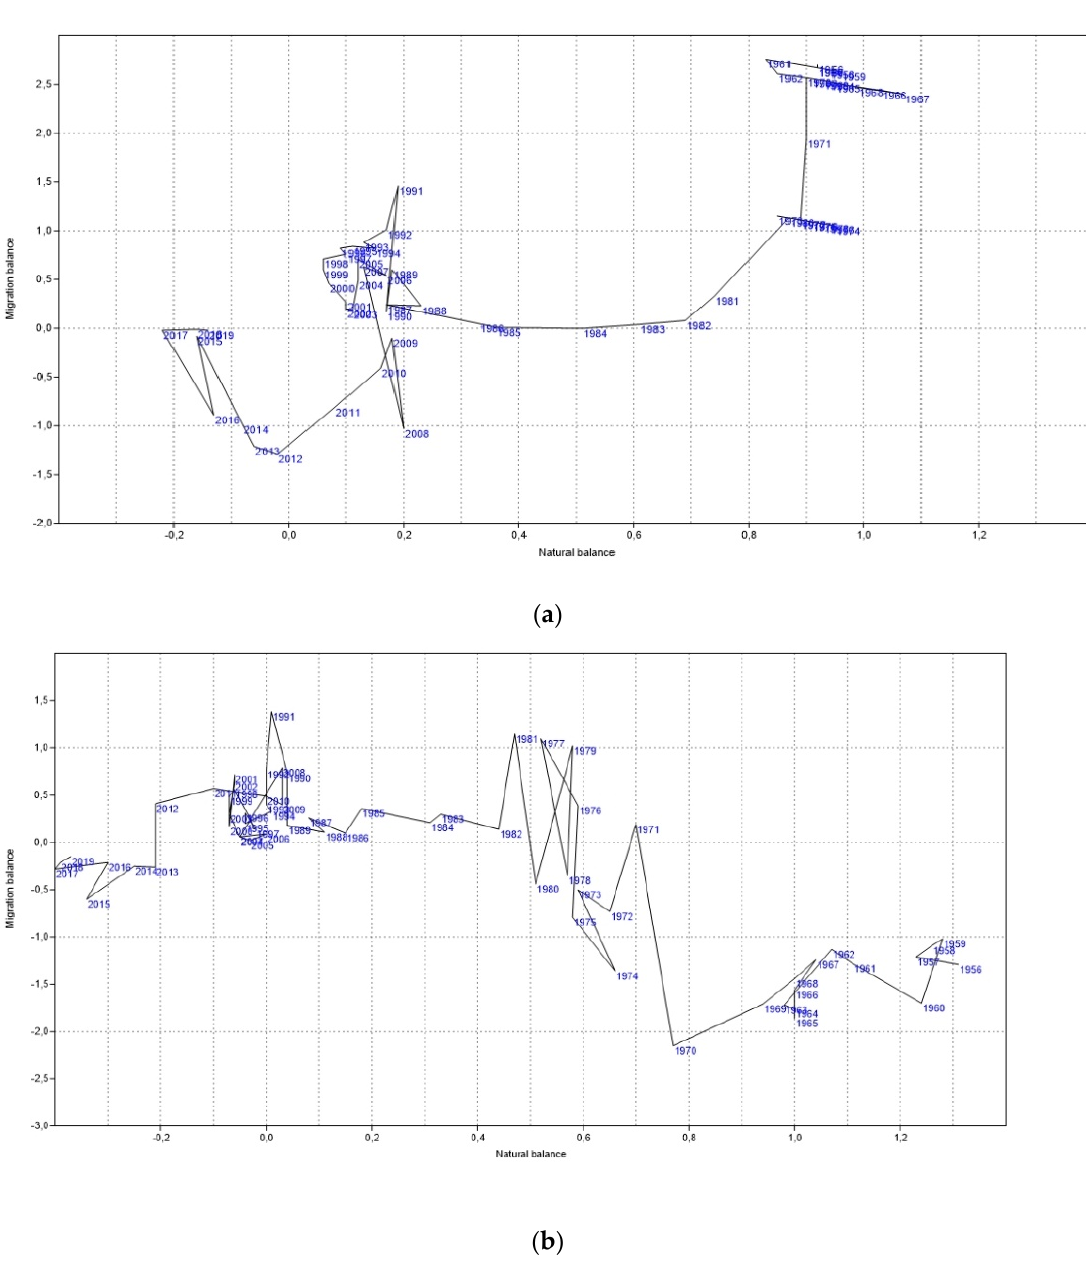
Figure 4. Scatterplots correlating natural and migration balances in Attica ( a ) and in the rest of Greece ( b ) over time (source: our elaboration on Eurostat regional statistics).